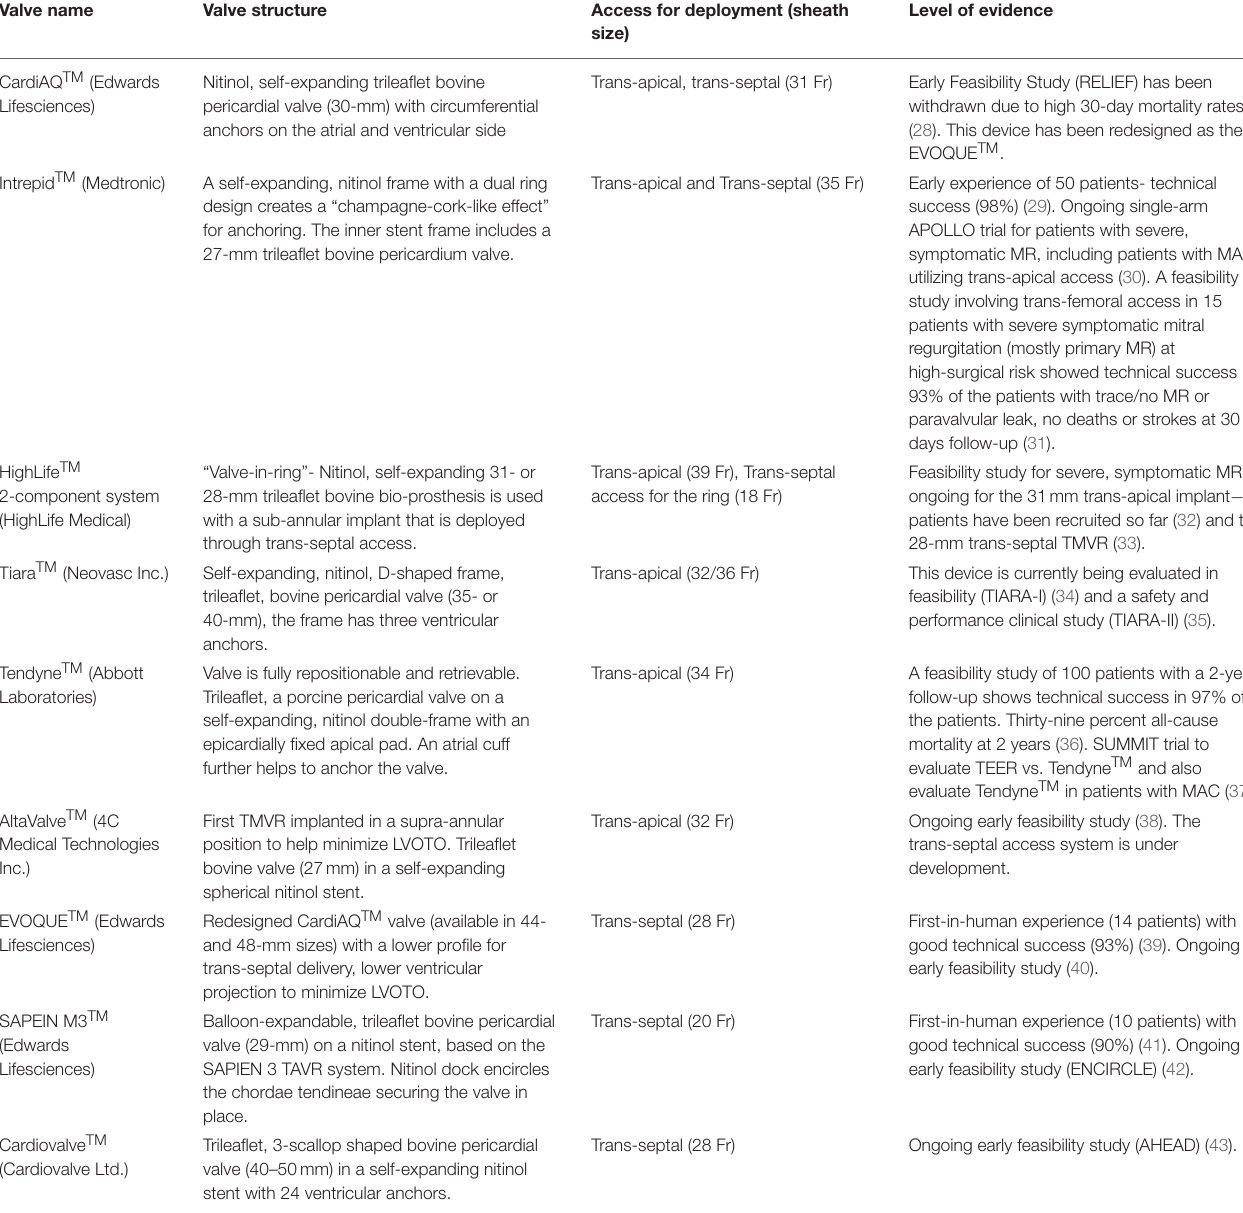
TABLE 1 | Descriptive analysis of the different Transcatheter Mitral Valve Replacement devices with human